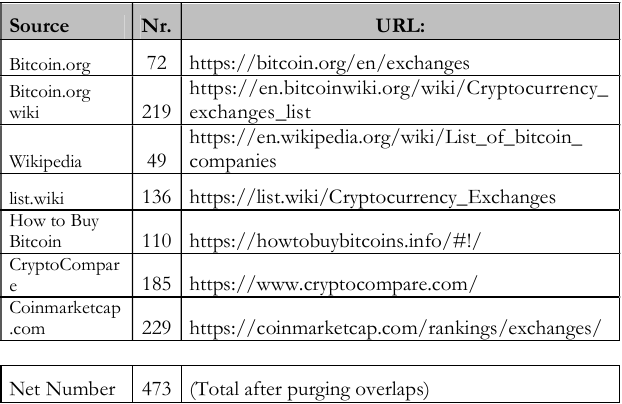
Table 1. Summary of Global Crypto Exchanges Information